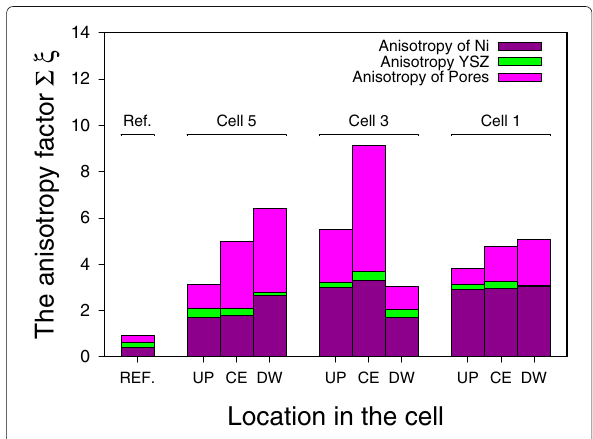
Fig. 8 The anisotropy factor at different location in the stack and in a cell, where UP, CE ,and DW refers to upstream, center, and downstream of a cell respectively and acronym REF corresponds to the reference